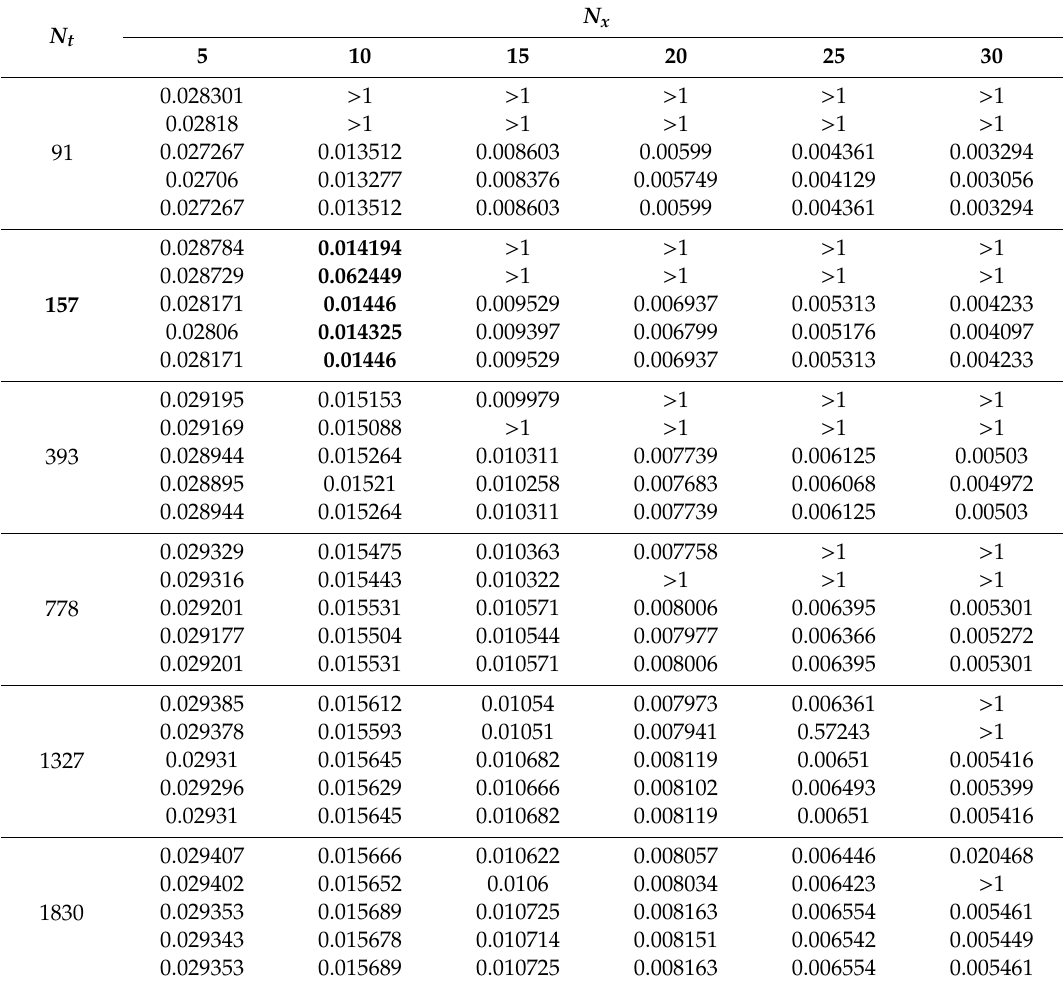
Table A4. Comparisons of maximum absolute values of relative errors (in comparison with the exact solution) for used di ff erence schemes and the generation